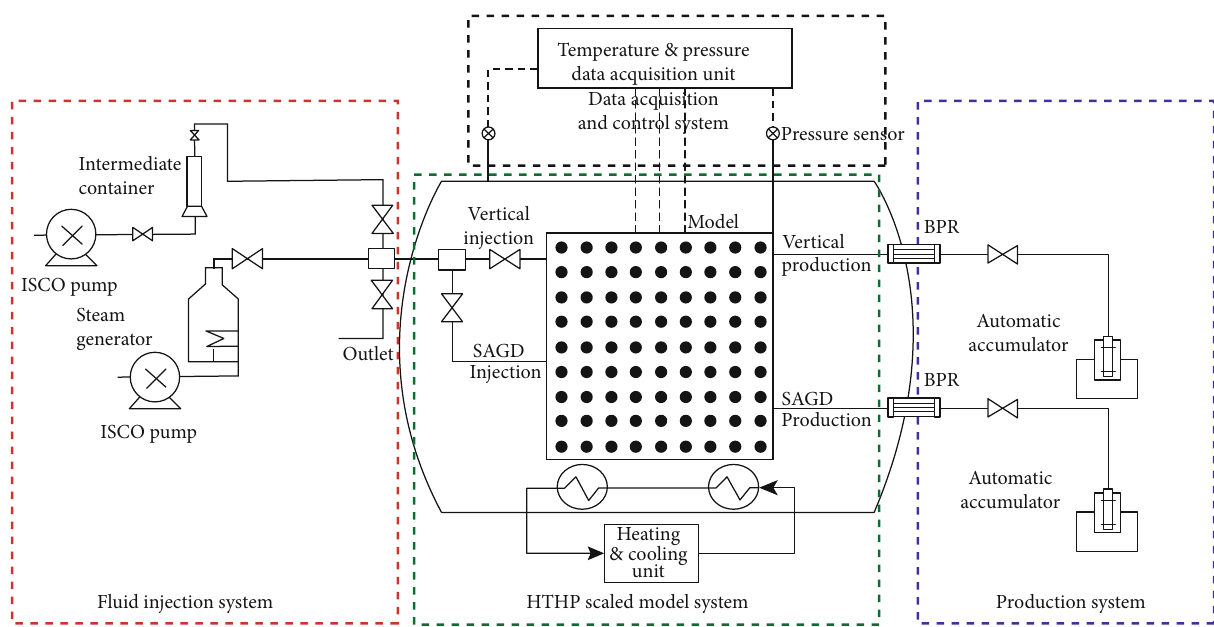
Figure 6: Flow chart of 2-D HTHP scaled physical experiment.